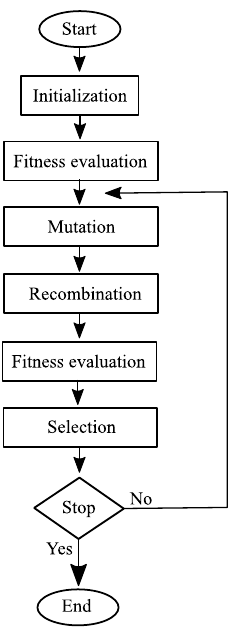
Figure 6. Flowchart of the differential evolution (DE) algorithm.